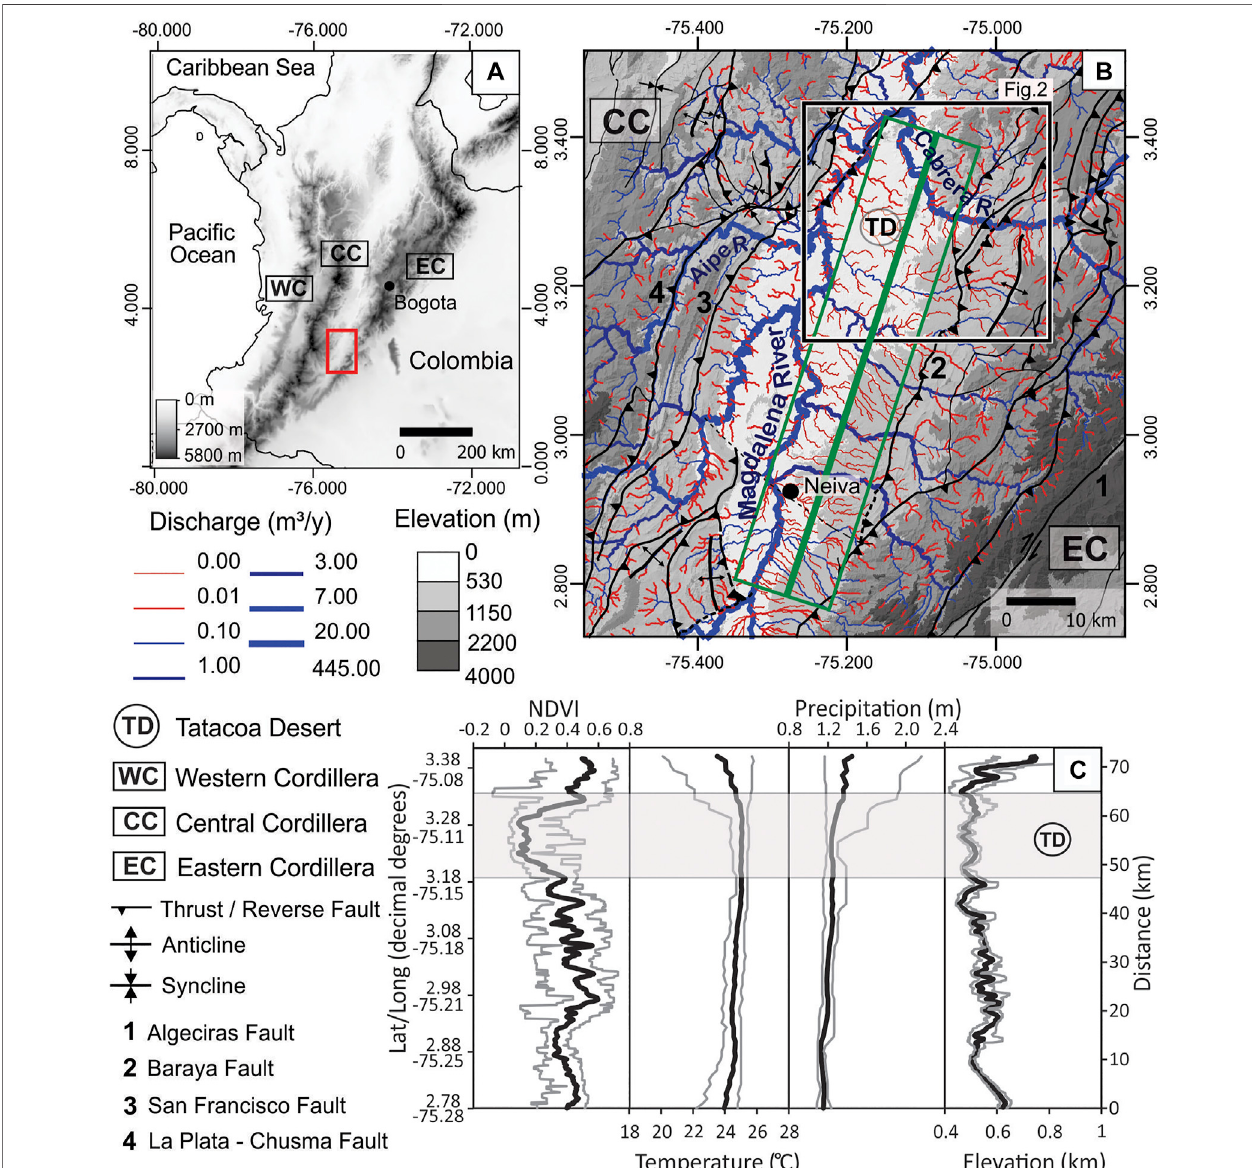
FIGURE1| LocationandregionalcontextoftheTatacoaDesert: (A) topographicmapshowingthelocationofthestudyareawithintheColombianAndes; (B) close-up view of the Upper Magdalena Valley. The location of a 20 km wide, along-strike swath pro fi le is shown by the green rectangle. A proxy for discharge was estimated by considering the drainage area, the mean annual precipitation, and the potential evapotranspiration index. The black square is the location of Figure 2 ; and (C) variation of vegetation (NDVI index ( Supplementary Figure S1 ) from Copernicus Copernicus Sentinel data, 2021), mean annual temperature, and mean annual precipitation (Chelsea database — Karger et al. (2017; 2017)) along the Upper Magdalena Valley. The thick black lines indicate the mean values across the swath pro fi le; the gray lines correspondtotheminimumandmaximumvalues.Itisnotedthattheswathpro fi leisinclinedtoNNE,thecoordinatesrefertothethickgreenlineinthecenteroftherectangle in (B) . See supplementary material for further information on the NDVI and discharge calculation. DEM data from German Aerospace Center-TanDEM-X, 2019.